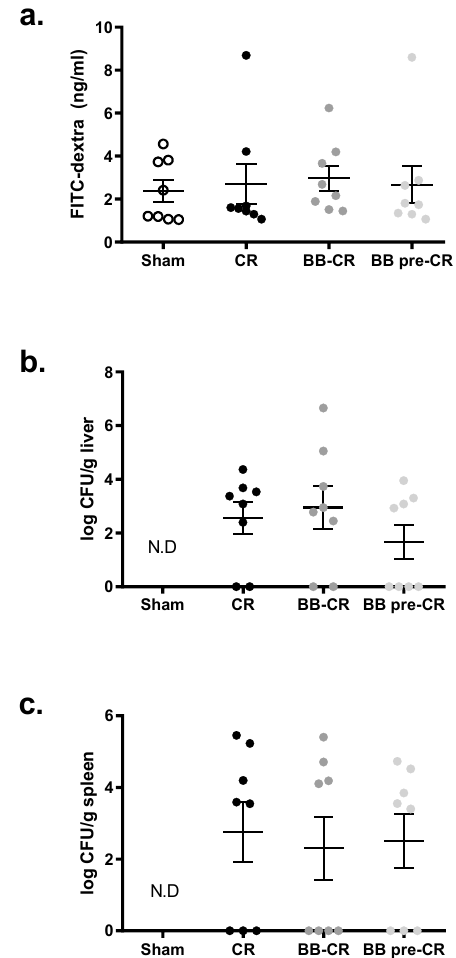
Figure 4. The effect of BB75 on the intestinal barrier at day 10 p.i. ( a ) In vivo FITC-dextran intestinal permeability test (n = 8/group); no difference was detected in intestinal permeability among the groups, despite C. rodentium or BB75 treatment; C. rodentium translocation to ( b ) liver and ( c ) spleen (n = 8/group); no difference in C. rodentium translocation was detected among groups. Results are presented as mean ± SE. Statistical significance was determined by one-way ANOVA. N.D, not detectable.